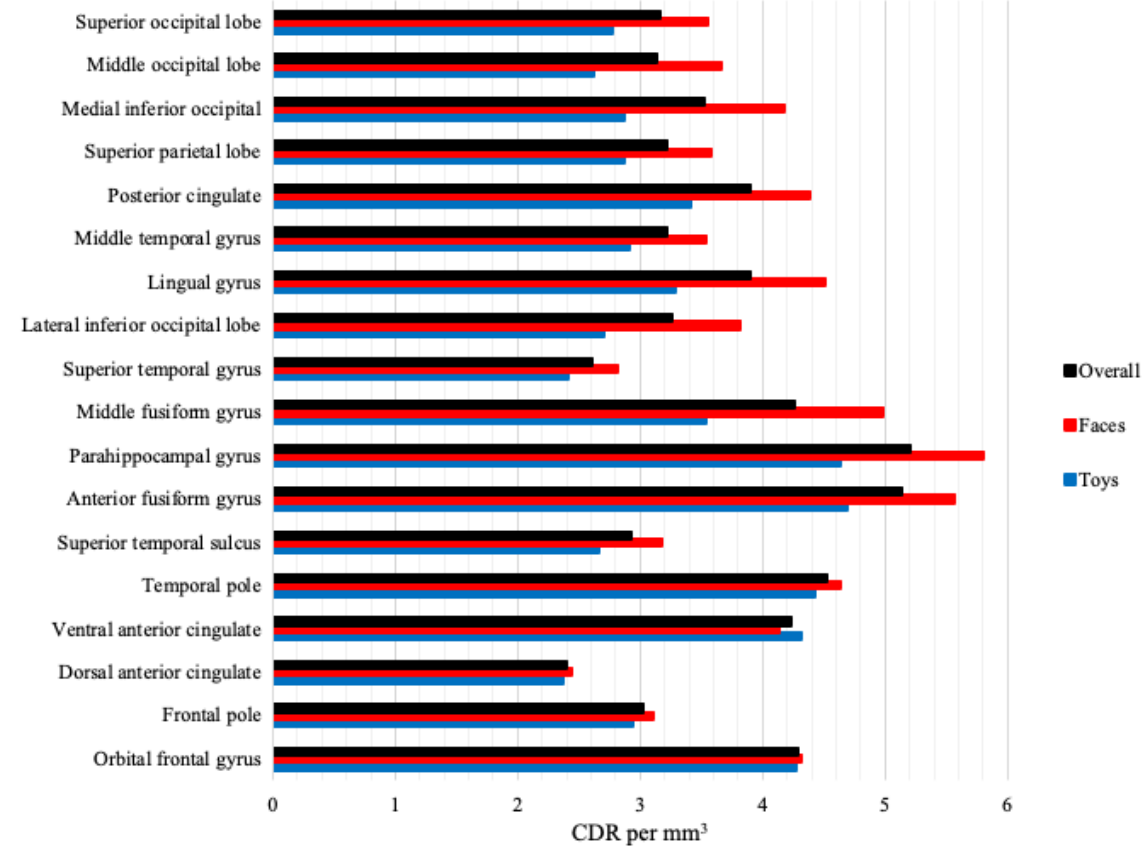
Figure 7. Level of CDR activation is examined across all ROIs as calculated for cortical source analysis using t.